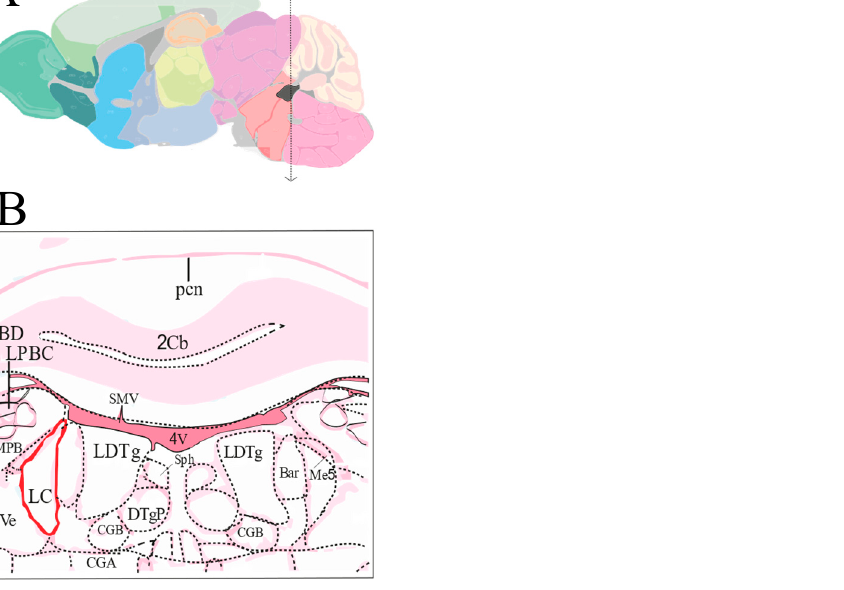
Figure 2. Anatomical localization of LC nucleus. ( A ) Sagittal section of the murine whole brain, each color distinguishes different regions in the brain, with black showing the localization of the LC nucleus in the pons of brainstem. ( B ) Cartoon showing the boundaries of the LC nucleus in red at the level of the Vth ventricle, compared to other surrounding structures in pink, where sections were dissected.